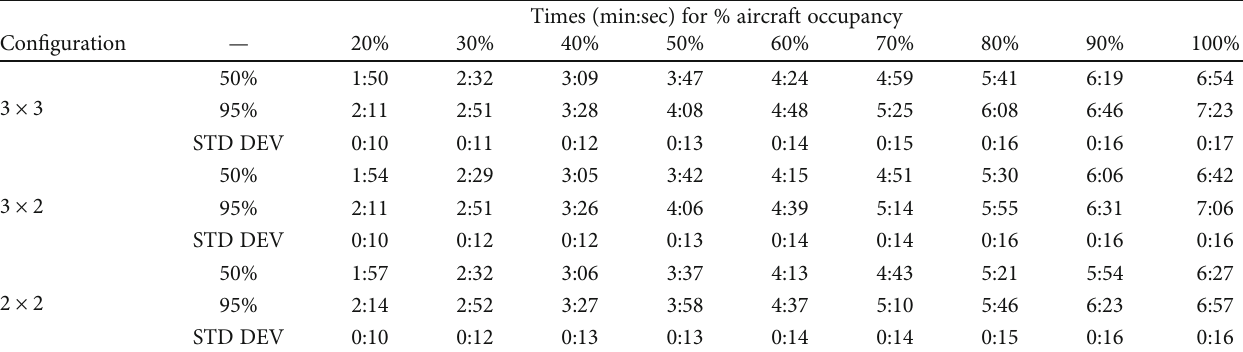
Table 7: Complete comparison of boarding times for the three aircraft con fi gurations using the random outside-in boarding strategy for di ff erent % of aircraft